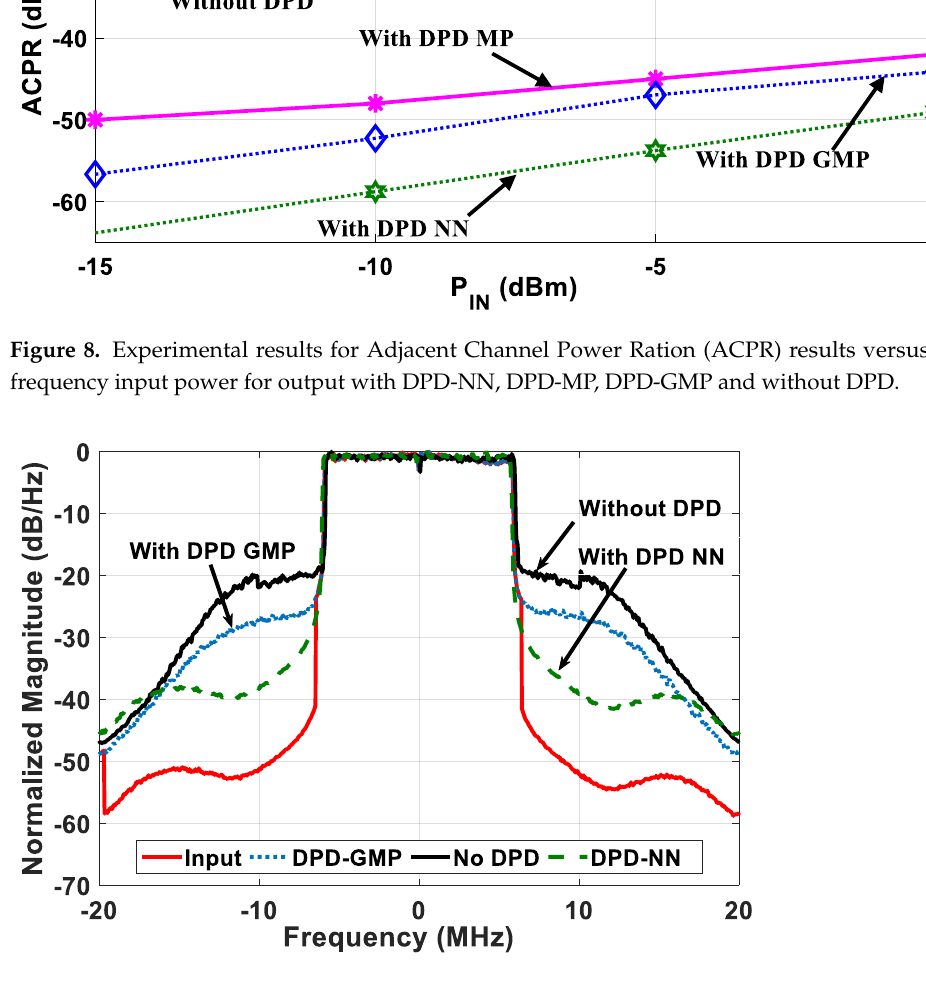
Figure 9. Spectral regrowth for output with DPD-NN, DPD-GMP and without DPD.